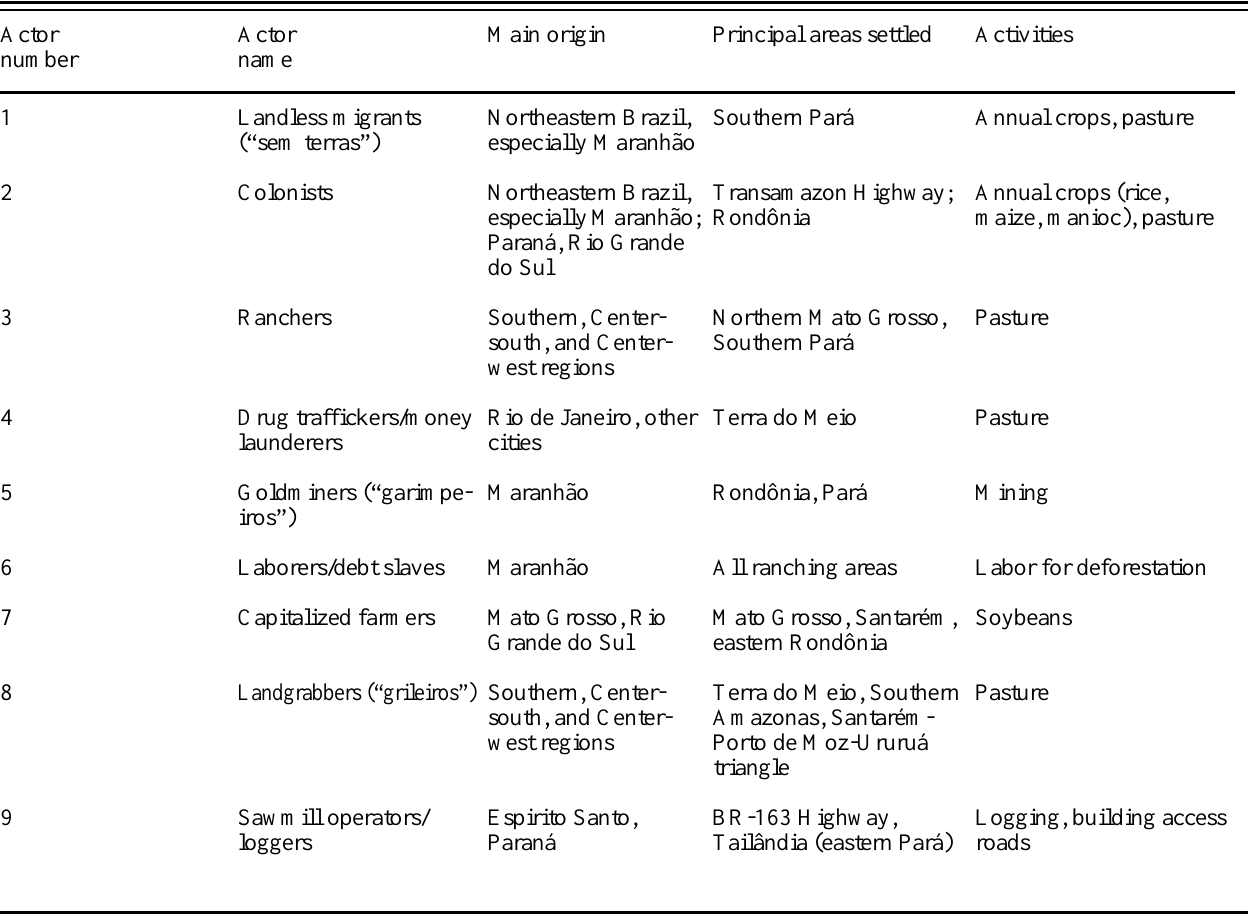
Table 1. Actors in Amazonian deforestation Actor